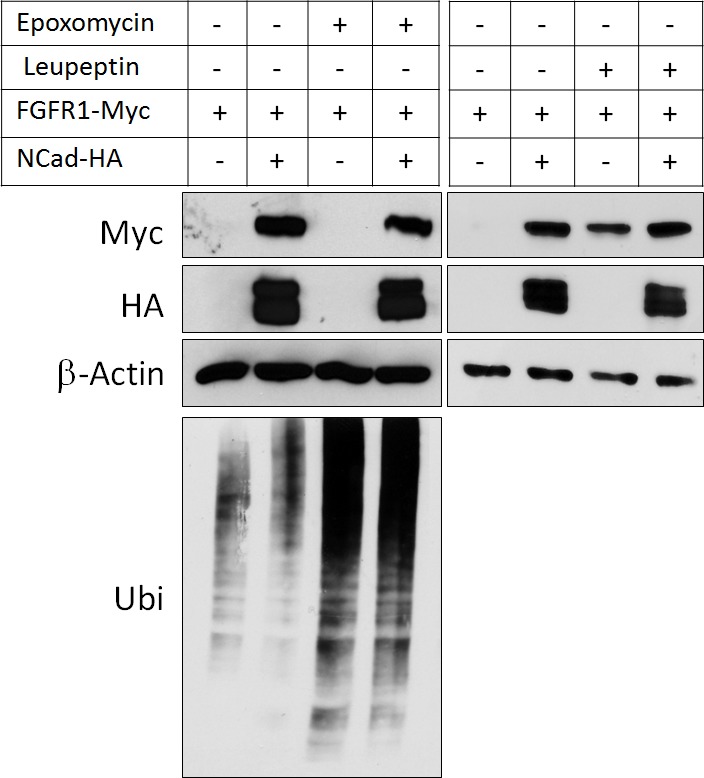
NCad over-expression and lysosomal inhibition increase FGFR1 protein level to the same extent.Cells co-transfected with pCAG-FGFR1-Myc and pCAG-NCad-HA or vector were incubated with 250 nM proteasome inhibitor epoxomycin or 300 µM lysosome inhibitor leupeptin for 4 hr and analyzed by Western blot. Epoxomycin inhibited proteasomal degradation of many ubiquitinated cell proteins, as indicated by an increase in total protein ubiquitination.